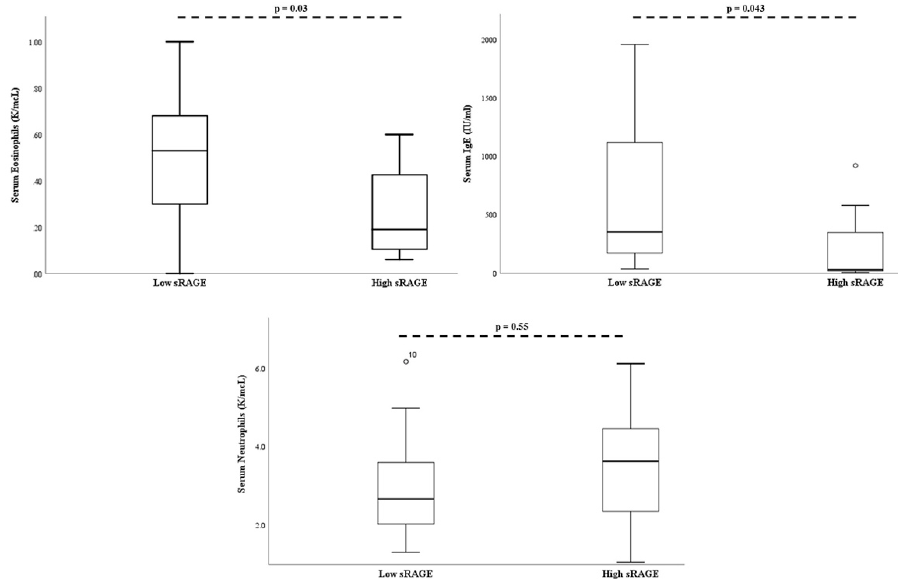
Figure 3. Bronchial alveolar lavage soluble RAGE is associated with decreased serum eosinophils and serum IgE. There was no association between soluble RAGE and serum neutrophil levels. P -values adjusted for age and BMI percentile. The open-circle denotes subjects outside the 95% confidence